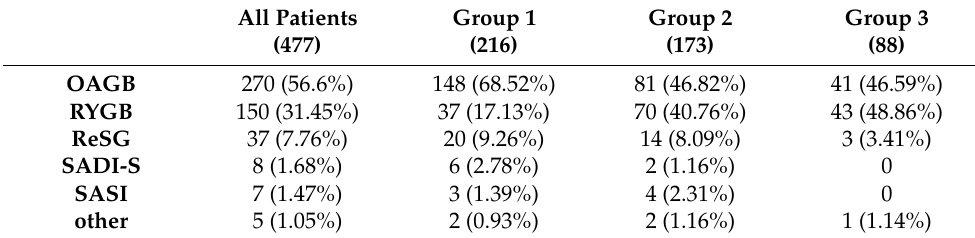
Table 3. Types of revisional procedure after primary sleeve gastrectomy. All Patients